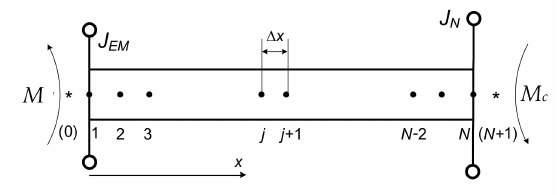
Figure 3. Long shaft